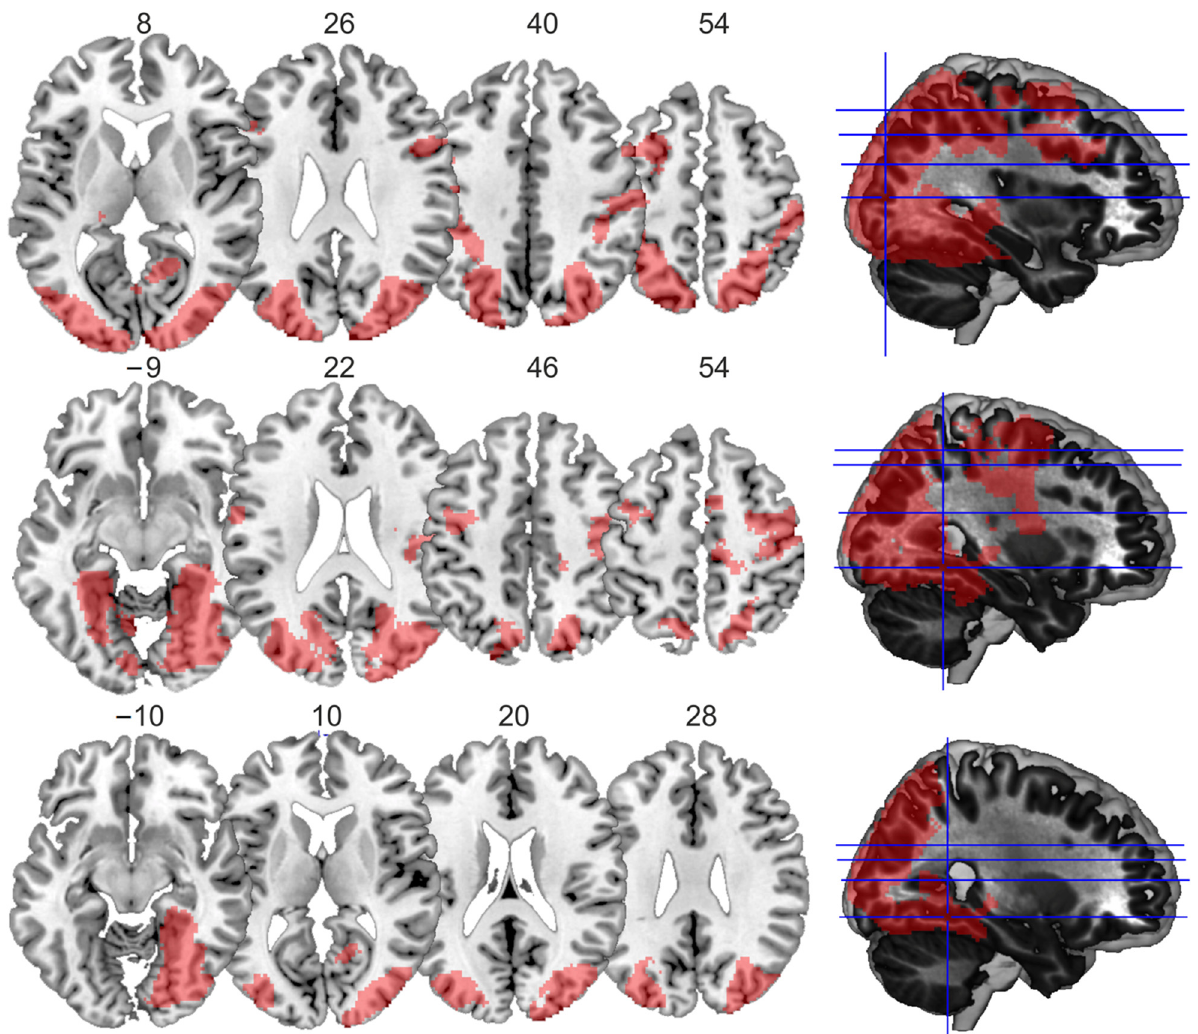
Figure 3. Visualization of the main effects and the conjunction. Main effects for display size ( top row ), familiar size ( middle row ), and the conjunction contrast ( bottom row ), as visualized using MRIcron. Slices were chosen based on the peak coordinates of the significant clusters, and the numbers correspond to the z-coordinates of the chosen slices, which are also illustrated in the respective rendered brains in the right column.